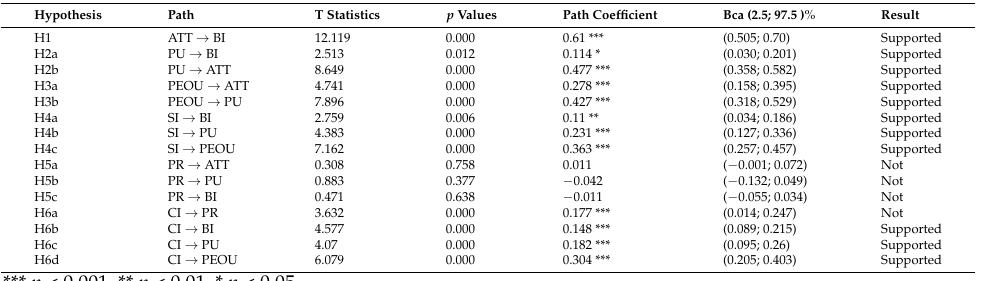
Table 6. Path coefficients and hypothesis